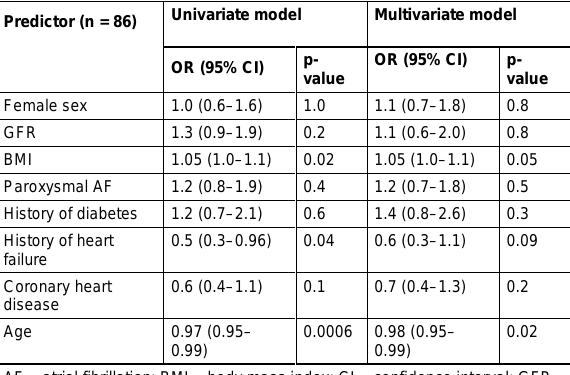
Table 3: Predictors for switch from vitamin K antagonists to non-vitamin K antagonist oral anticoagulants. Predictor (n =